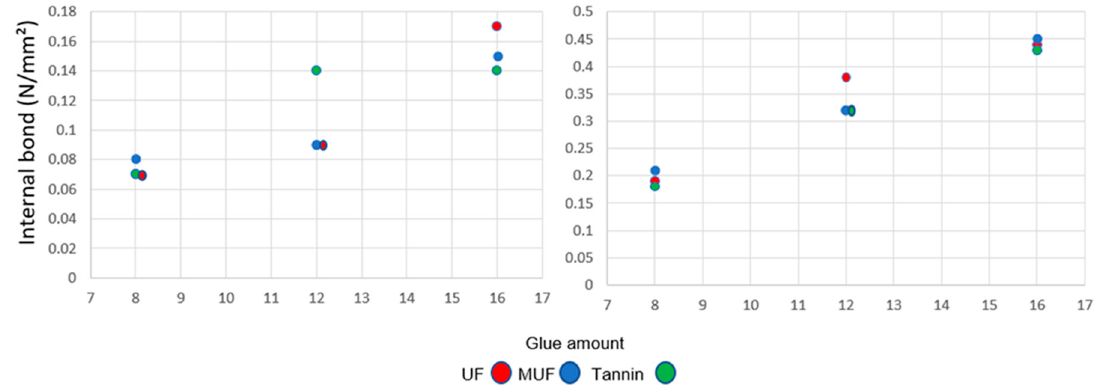
/ m 3 ( left ) and 500 kg / m 3 ( right ).